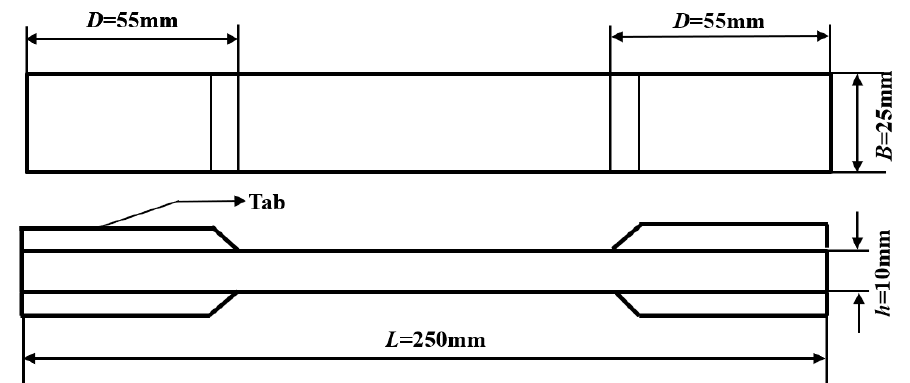
Figure 2. Schematic diagram of the specimen.